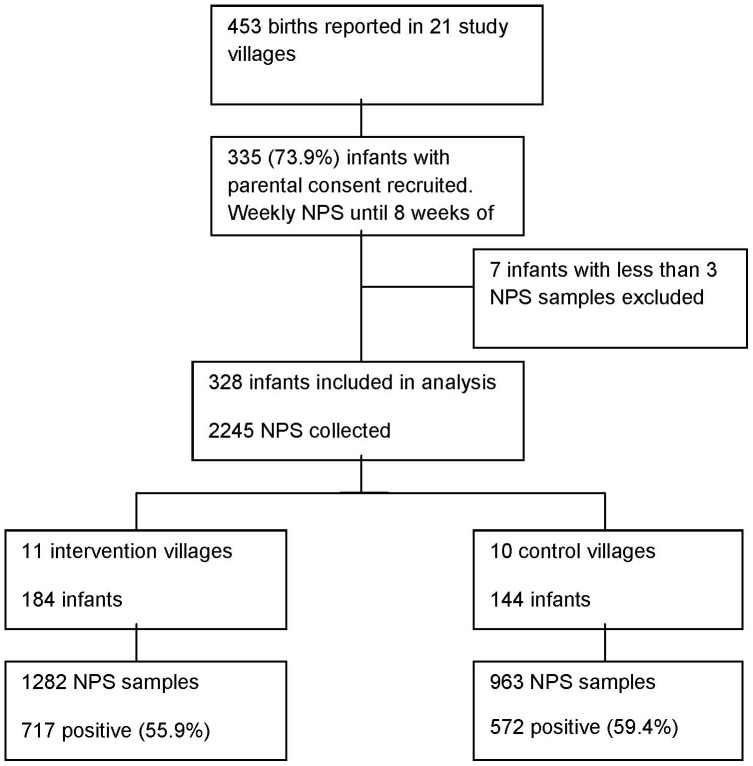
Summary of recruitment, nasopharyngeal samples collected and pneumococci isolated from infants in 21 study villages.